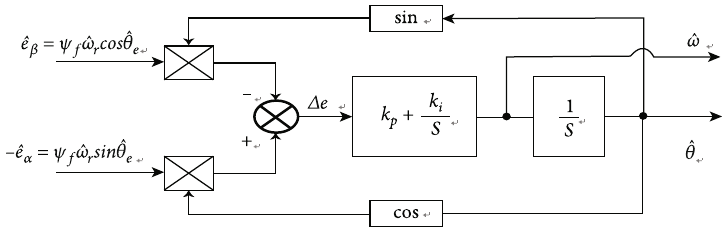
Figure 6: Block diagram of the PLL architecture.